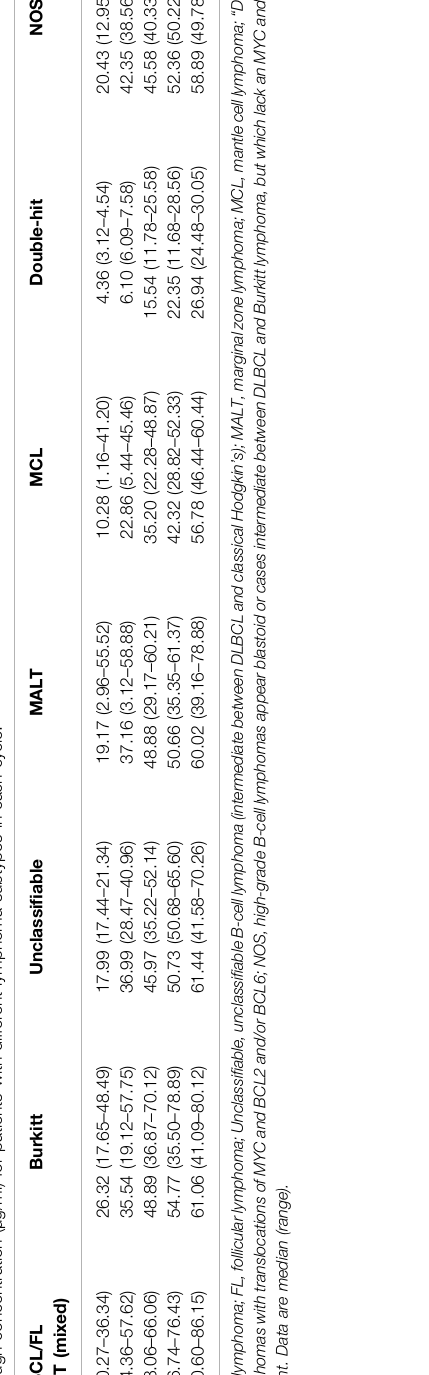
The rituximab C 1-trough for patients with Burkitt lymphoma ranged from 17.65 to 48.49 μ g/ml ( Table 3 ). Of the 11 patients, four patients had lactate dehydrogenase (LDH) levels higher than 250 U/L before treatment. However, among these patients, only one failed fi rst-line treatment, and then the disease rapidly became uncontrolled (OS was 12 months) with a C 1-trough T A